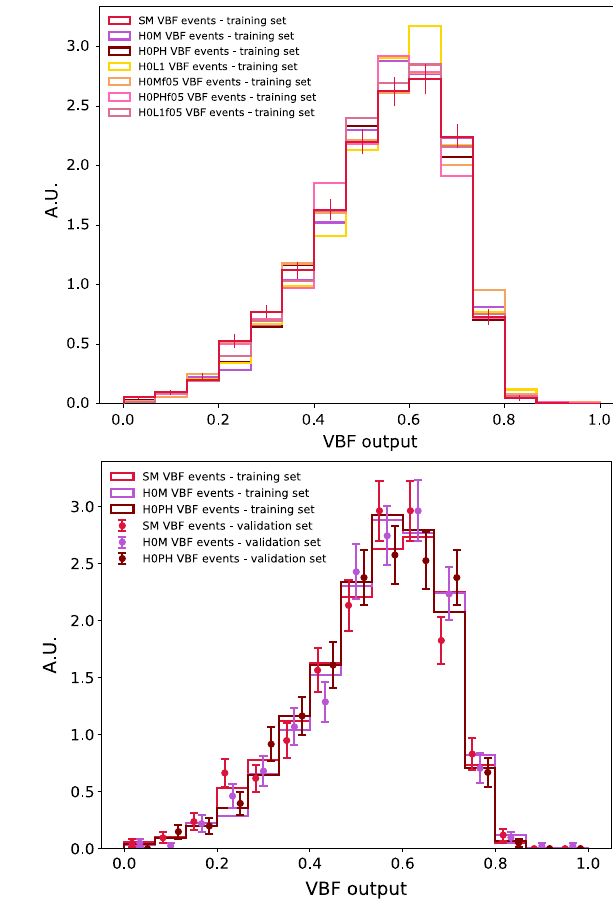
Fig. 3 Normalized distributions of the VBF-output on signal events simulatedunderthesevenconsideredhypotheses,evaluatedonthetrain- ing sample (top) in C1. The uncertainty associated with the limited size of simulated samples is reported only in the SM distribution. Three dis- tributions related to the SM, H0M and H0PH models have been tested simultaneouslyinthetrainingandvalidationsample(bottom).Thesolid lines correspond to the distributions obtained on training set, while the dots with statistical error bars stand for validation